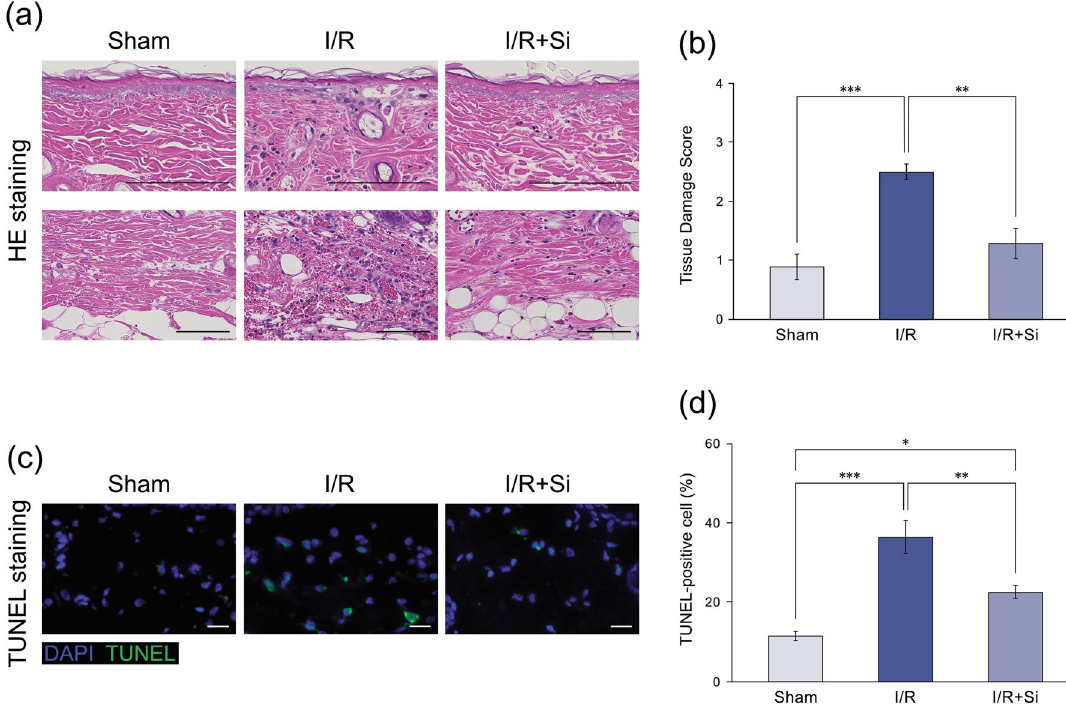
Figure 3. HE and TUNEL staining analysis of skin flap after ischemia–reperfusion injury. ( a ) Representative HE staining images of the superficial and deep layers of the skin flap tissue of each group (scale bar: 100 μm). Inflammatory cell infiltration, hyperemia, and intra-vascular microthrombosis were severe in the I/R group. ( b ) Tissue damage score evaluation. The score for the I/R + Si group was significantly lower compared to the I/R group. ( c ) Representative TUNEL staining images of the dermis of the skin flap tissue of each group (scale bar: 20 μm). ( d ) TUNEL-positive cell evaluation. The percentage of TUNEL-positive cells in the I/R + Si group was significantly lower compared to the I/R group (* p < 0.05, ** p < 0.01, *** p < 0.001; Tukey’s HSD multiple comparisons test, bars represent standard errors of